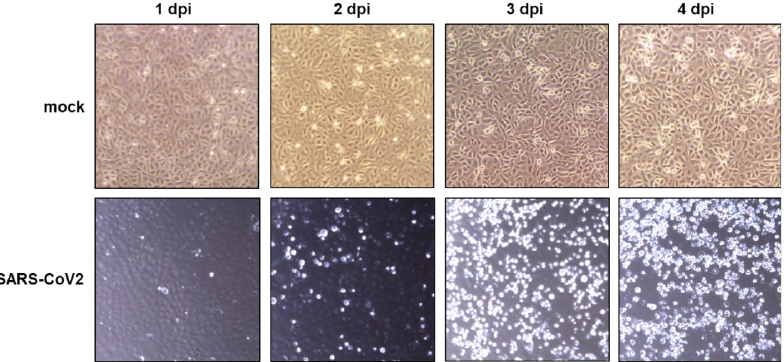
Figure 3. Optical comparison of mock and SARS-CoV-2 infected VeroE6 cells. An amount of 4.5 × 10 6 freshly thawed Vero-E6 cells were seeded in a laminin-coated CCU and incubated at 37 °C for 48 h. For mock infection, media was changed every 24 h and a microscopic picture was taken. For SARS-CoV-2 infection, cells were infected with an MOI of 0.01 for 4 h, after which media was changed every 24 h and an automatic picture was taken every 12 h. Shown are representative pictures for matched time points as indicated. All steps of the SARS-CoV-2 infection were performed within the CliniMACS Prodigy, while the mock control cultures were maintained without CliniMACS Prodigy. Dpi: days post infection.